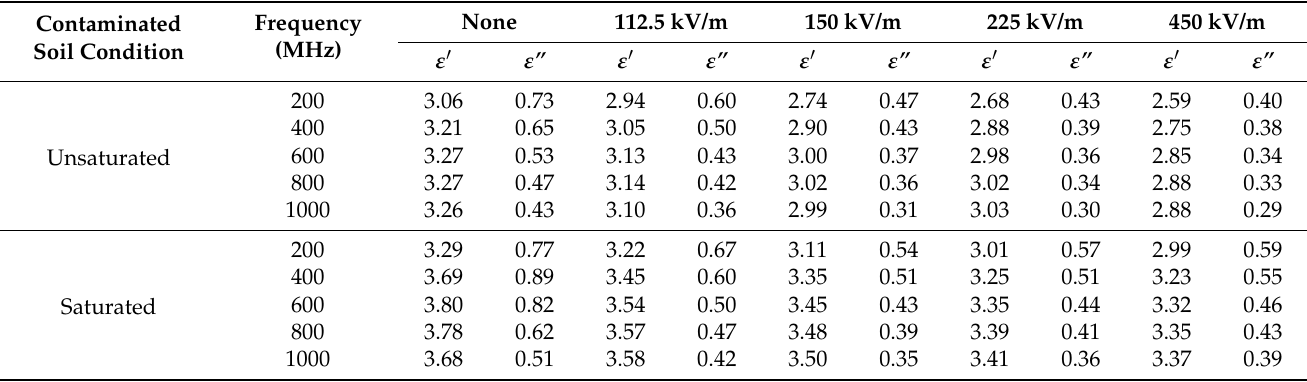
Table 2. Dielectric properties of heated soil samples based on the highlighted